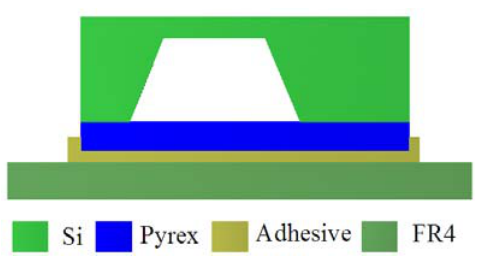
Figure 5. Schematic of packaged